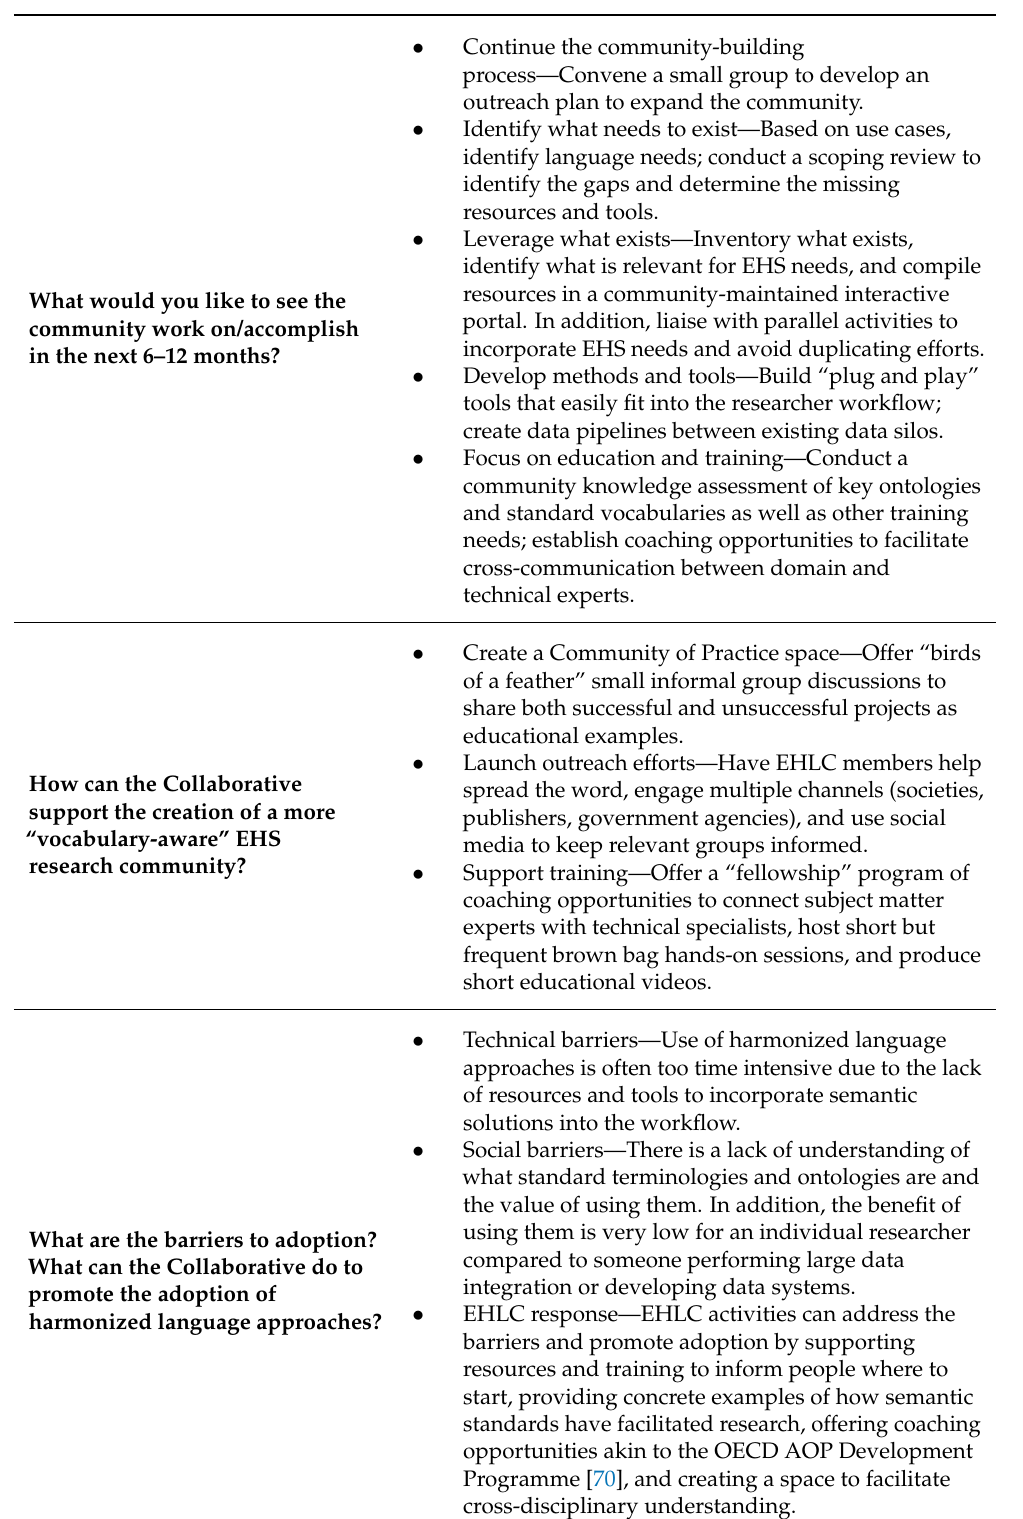
Table 5. Attendee feedback on four questions about future EHLC